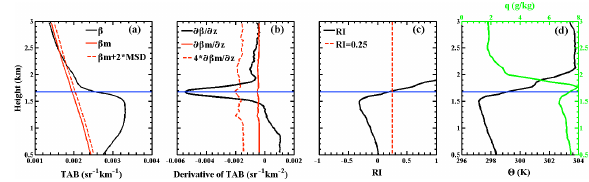
Figure 5. Illustrations of MPL BLH identification methods for continental measurements during daytime (17:30, April Fig. 5. Illustrations of MPL BLH identification methods for conti- 23, 2007): (a) TAB; (b) TAB gradient; (c) RI; (d) potential temperature and mixing ratio. The blue line in each figure denotes the Sonde derived BLH. nental measurements during daytime (17:30LT, 23 April 2007): (a) Over ocean, the threshold method could be used to determine the BLH. BLH is TAB; (b) TAB gradient; (c) RI; (d) potential temperature and mix- ing ratio. The blue line in each figure denotes the SONDE-derived defined at where TAB> 𝛽 ! ! ! ! , here 𝛽 ! ! ! ! is defined as 𝛽 ! ! ! ! = 𝛽 ! ! + 2 𝑀𝐵𝑉 , (2) where, 𝛽 ! ! is the attenuated molecular backscattering, estimated based on temperature and pressure profiles from SONDE data or from other sources; MBV